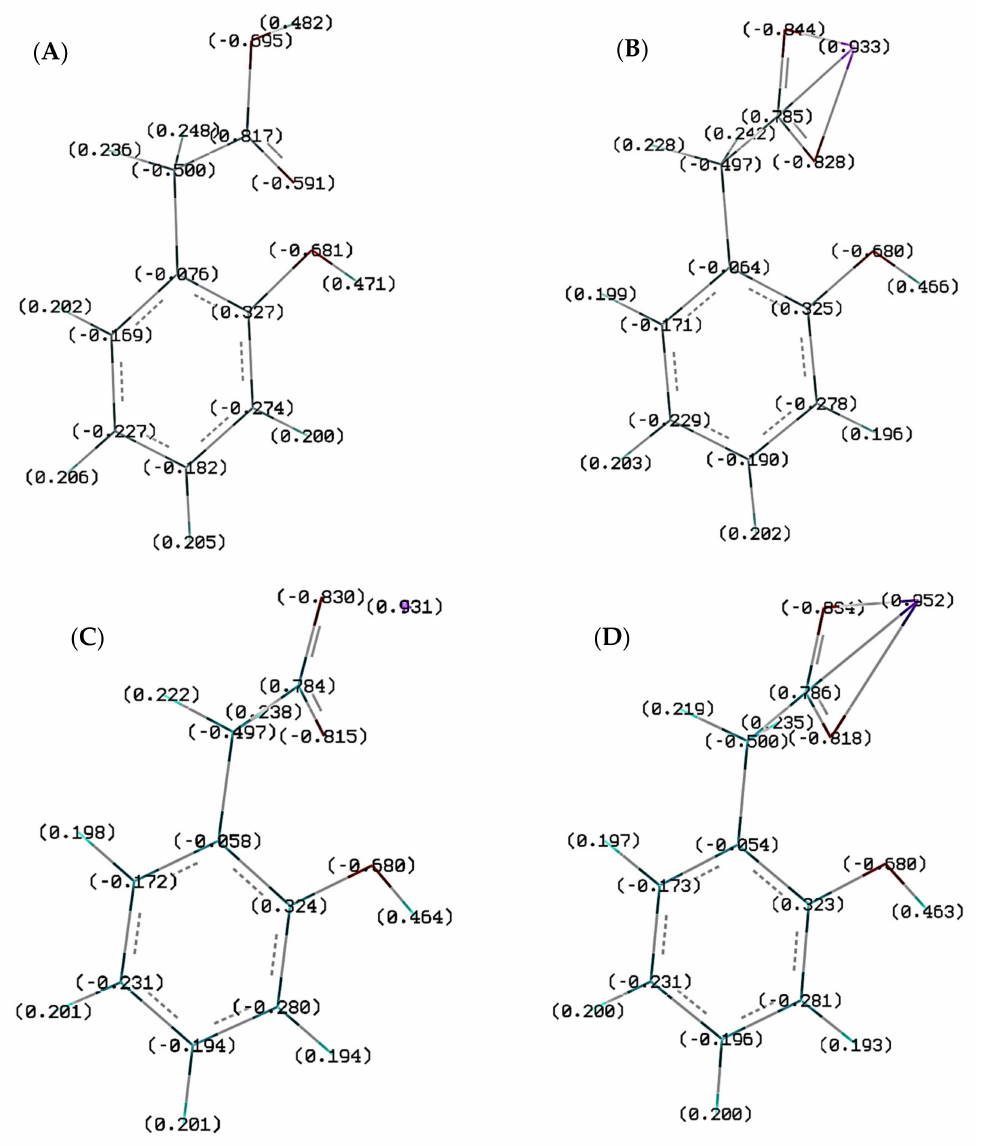
Figure 4. Electronic charge distribution in optimized molecules of ( A ) 2-HPAA, ( B ) Li 2-HPA, ( C ) Na 2-HPA, and ( D ) K 2-HPA calculated by NBO